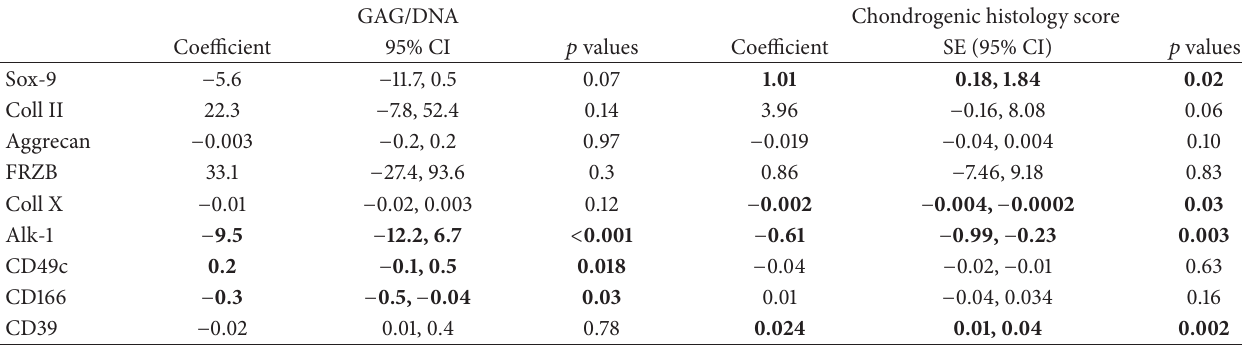
Table 2: Multilevel